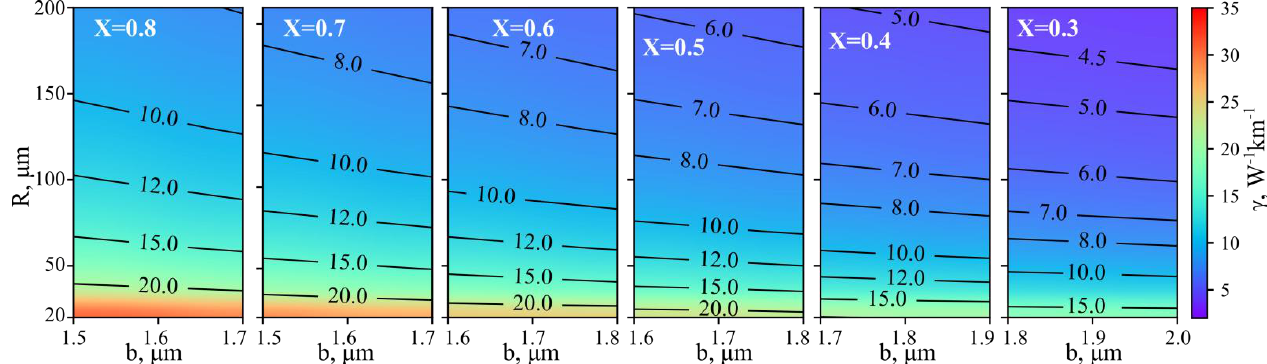
Figure 6. Calculated nonlinear coefficient γ in the parameter range that provides near-optimal GVD curves. All figures share the same colormap.